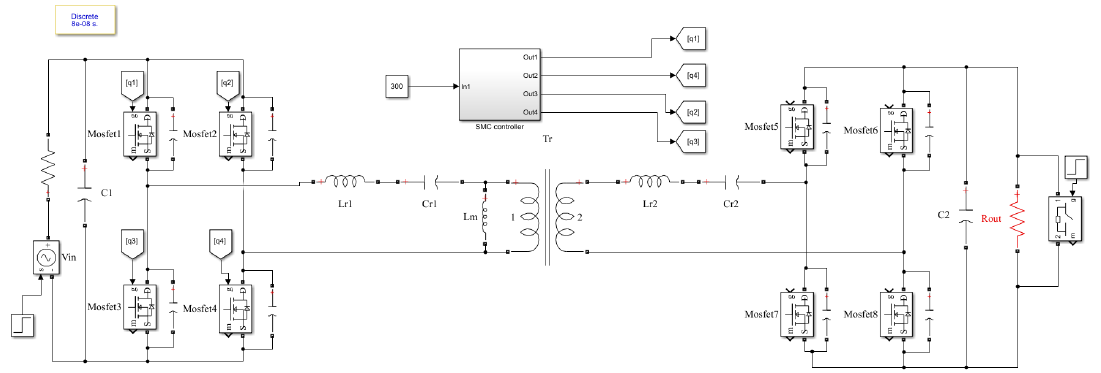
Figure 5. Experimental simulation model.